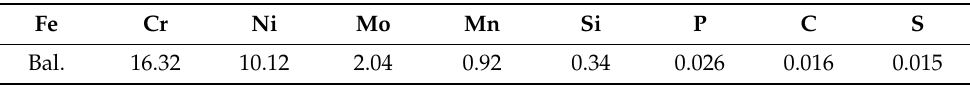
Table 2. Chemical composition of AISI 316 L stainless steel substrate (wt.%).